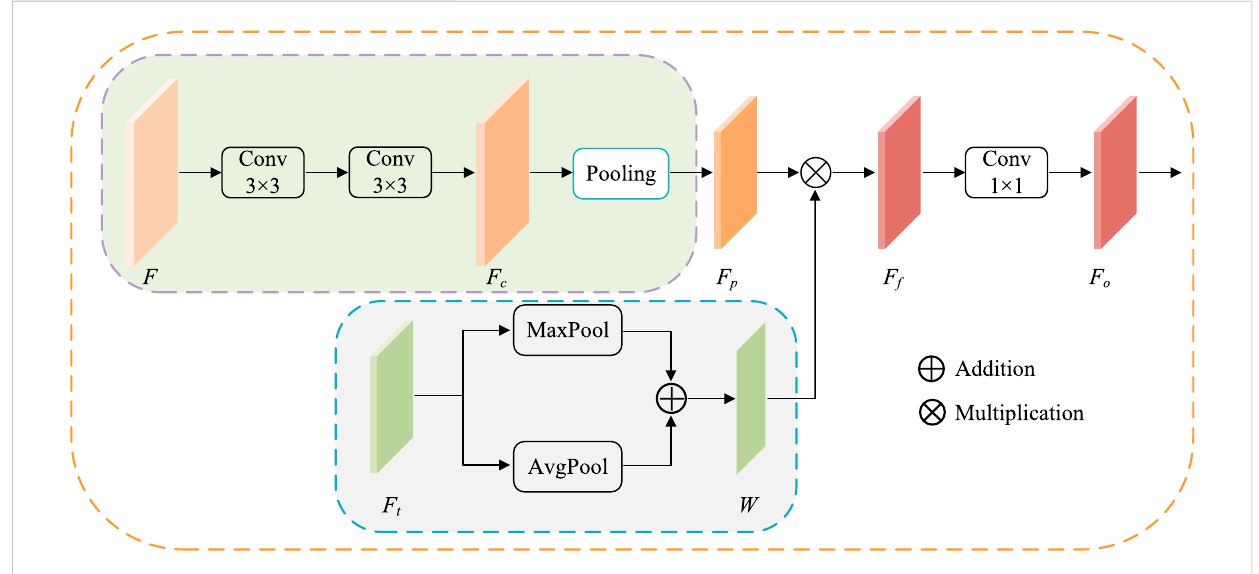
FIGURE 4 The structureofATAC.Poolingrepresents theregular max-pooling operationwith thepooling size 2. Maxpool andAvgPool representmax-pooling operation and average-pooling operation along the channel axis